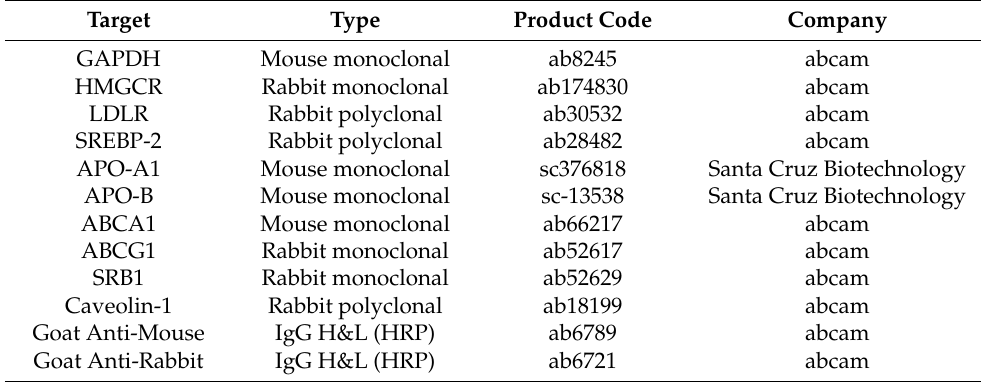
Table 2. Antibodies used in